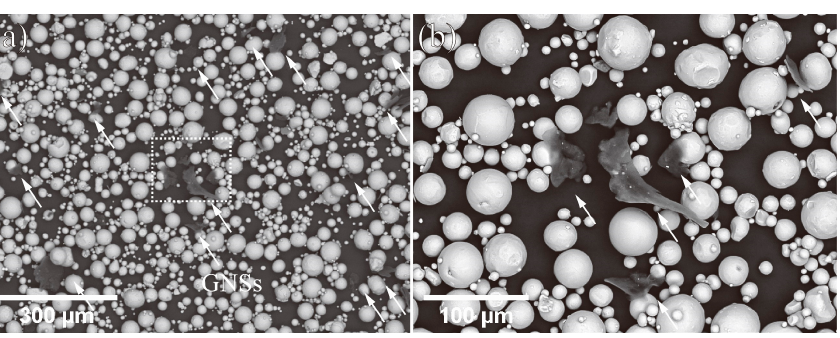
Figure 4. SEM images of #1 GNSs/Ti64 composite powders via rocking milling ( a ), GNSs among powders ( b ), GNSs on the surface ( c ), and EDS spectra ( d ).